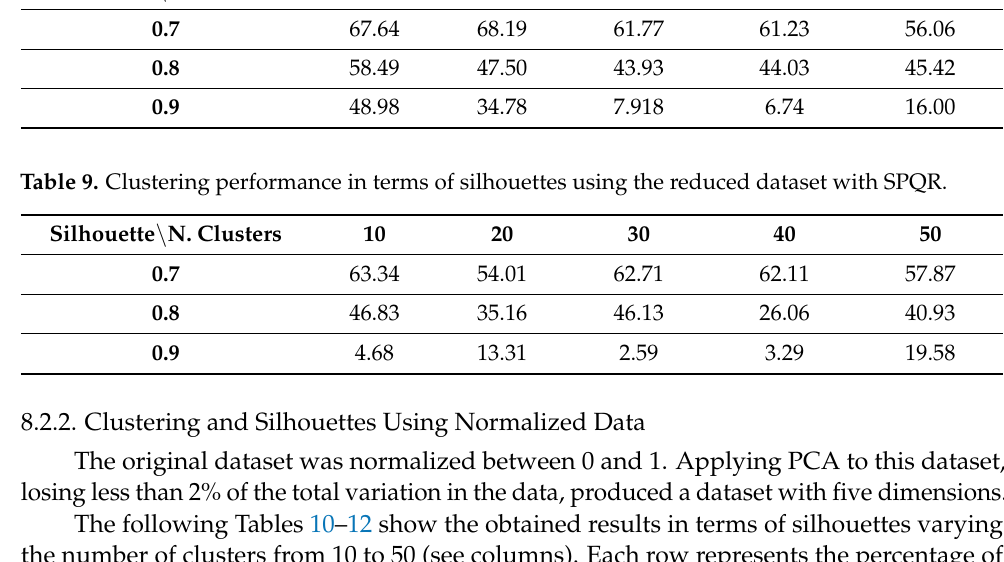
Table 8. Clustering performance in terms of silhouettes using the reduced dataset with PCA. Silhouette \ N. Clusters